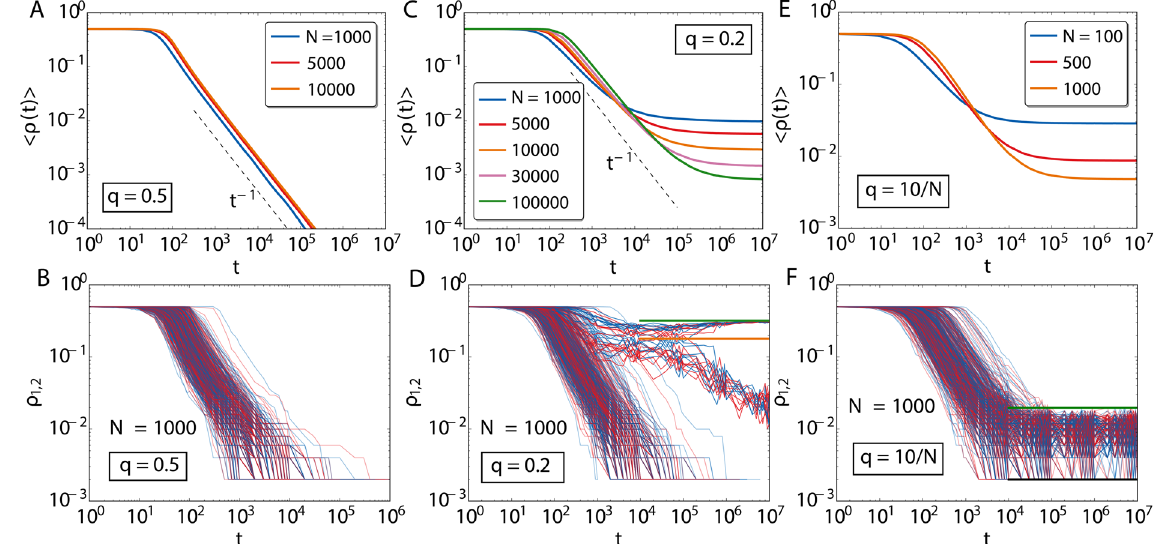
Figure 4. Average fraction of active links as a function of time over 1000 realizations (panels (A, C and E)). In panels (B, D and F) the corresponding values ρ 1 (blue) and ρ 2 (red) for each layer, for 300 individual realizations of the dynamics. The fraction of active links is displayed for q = 0.5 (first column), q = 0.2 (second column) and q = 10/ N (third column). The green horizontal line in panels (D and F) correspond to the predicted ρ up of equation (5). The orange line in panel (D) is the value of ρ half calculated in equation (6). The black horizontal line in panel F corresponds to ρ low of equation